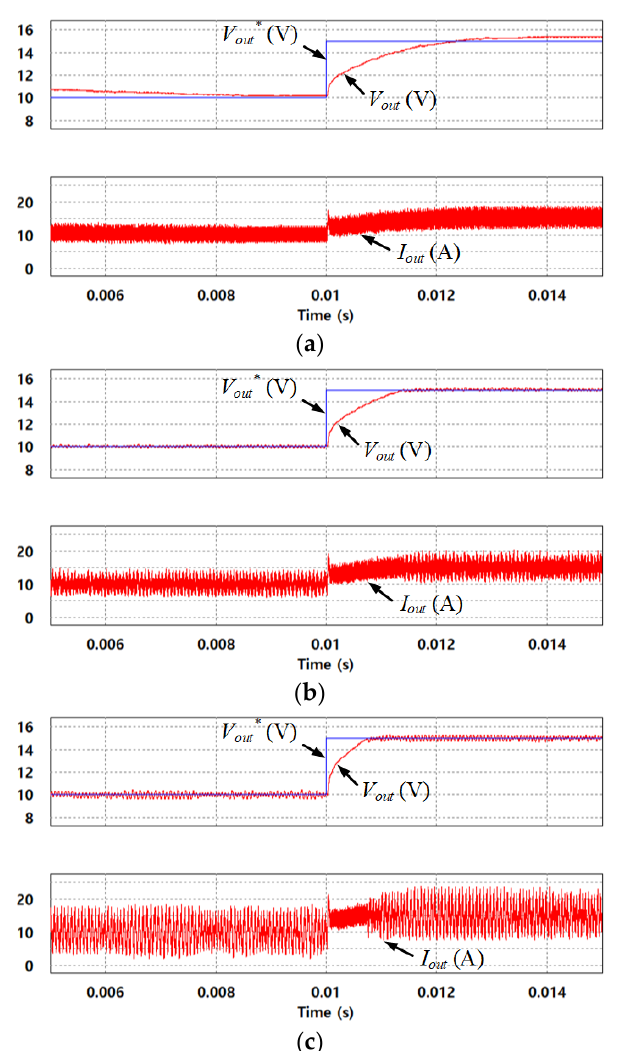
Figure 11. Simulation results of the PSFB-CT converter using the SMC depending on K SMC . ( a ) K SMC = 0; ( b ) K SMC = 1; ( c ) K SMC = 3.